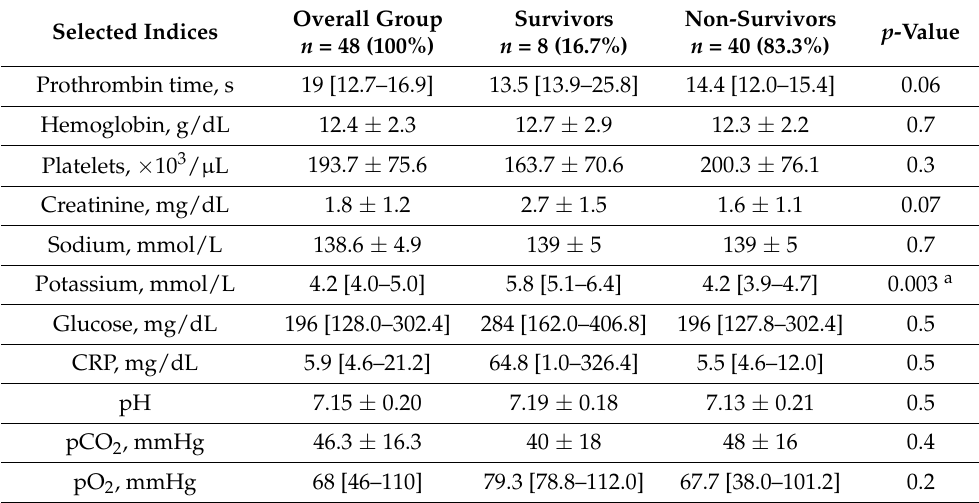
Table 2. Biochemical